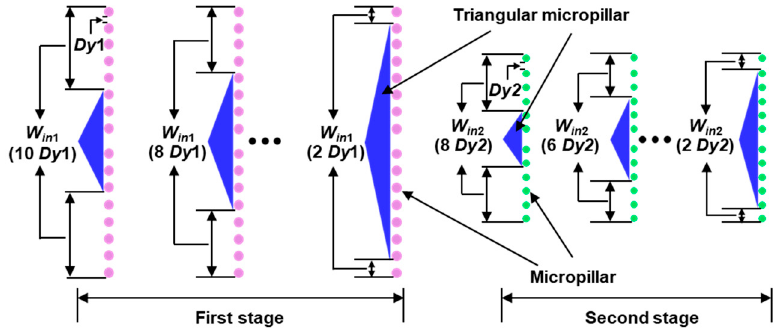
Figure 2. Schematic illustration of different inlet widths for the first and second stages.